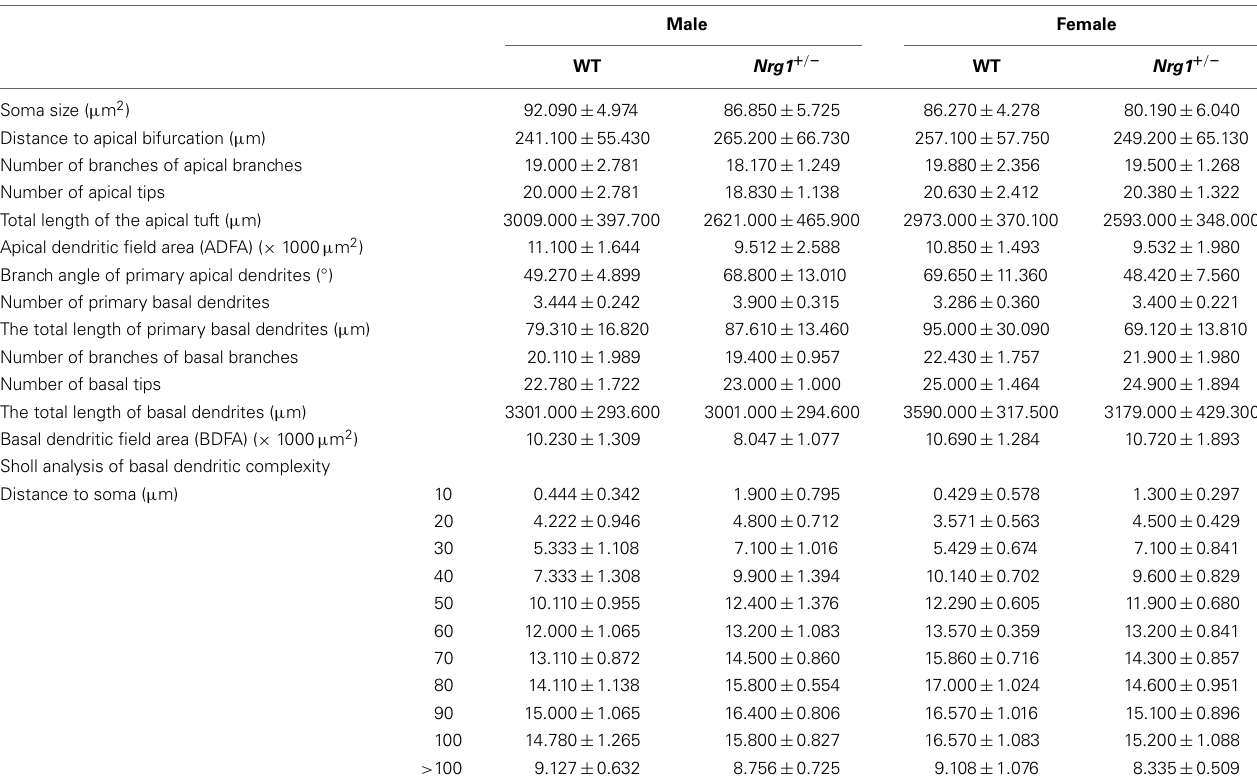
Table 2 | Neuromorphological analyses (mean ± s.e.m.) of GFP-labeled pyramidal neurons in the hippocampi of male and female TMc- Nrg1 + / − ( Nrg1 + / − ) mice and their wild-type (WT) littermate